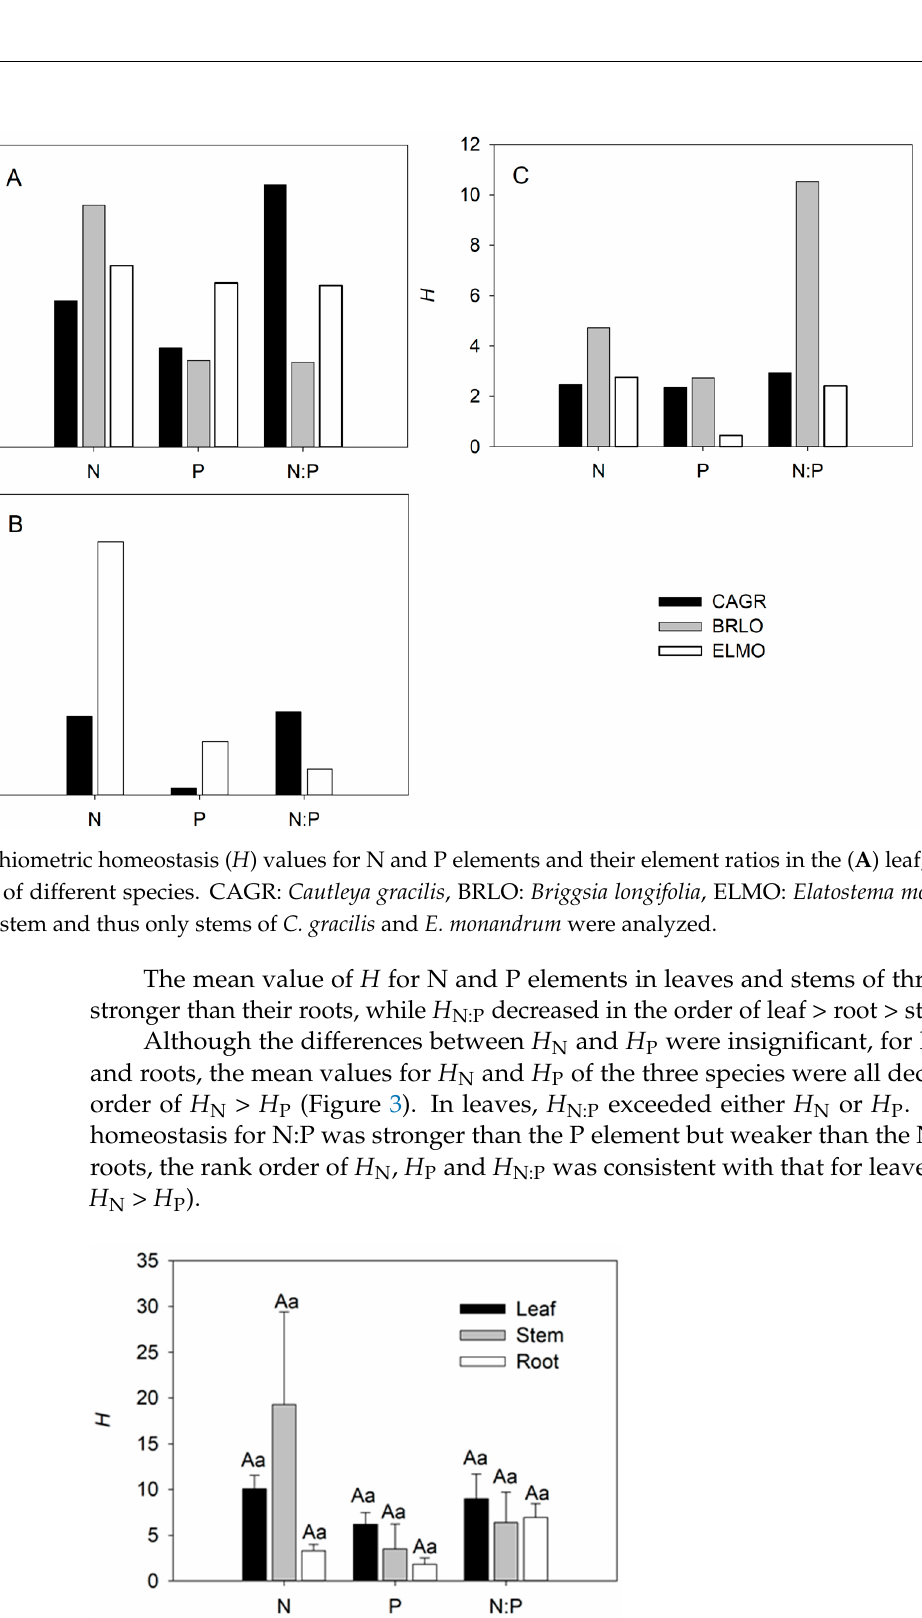
Figure 3. The mean stoichiometric homeostasis ( H ) values for the N and P elements and their ratios in leaves, stems, and roots of three species. Bars are the mean values with standard error. Capital and lowercase letters indicate significant differences among organs and element types, respective- ly.